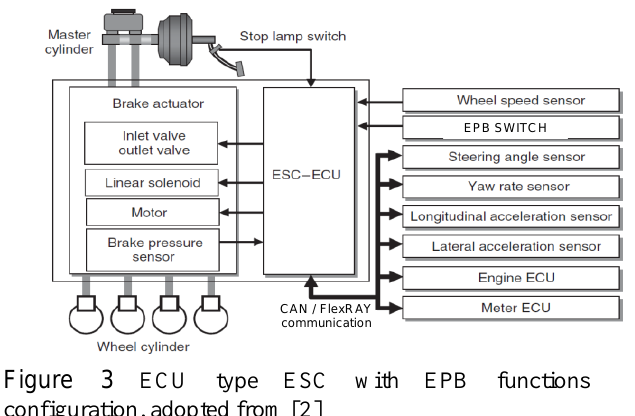
3 ECU type ESC with EPB functions configuration, adopted from [2]